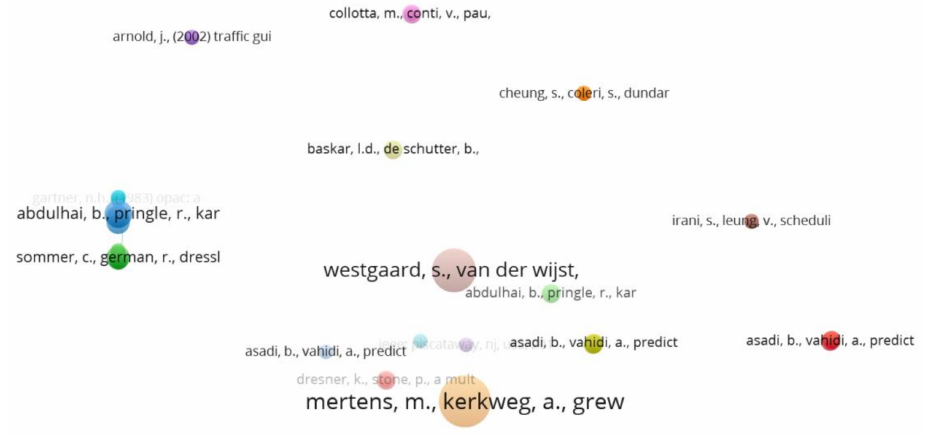
Figure 4. Reference visualization of database list “A”: the resulting network is poorly connected, showing a possible underdeveloped stage for this field of research.